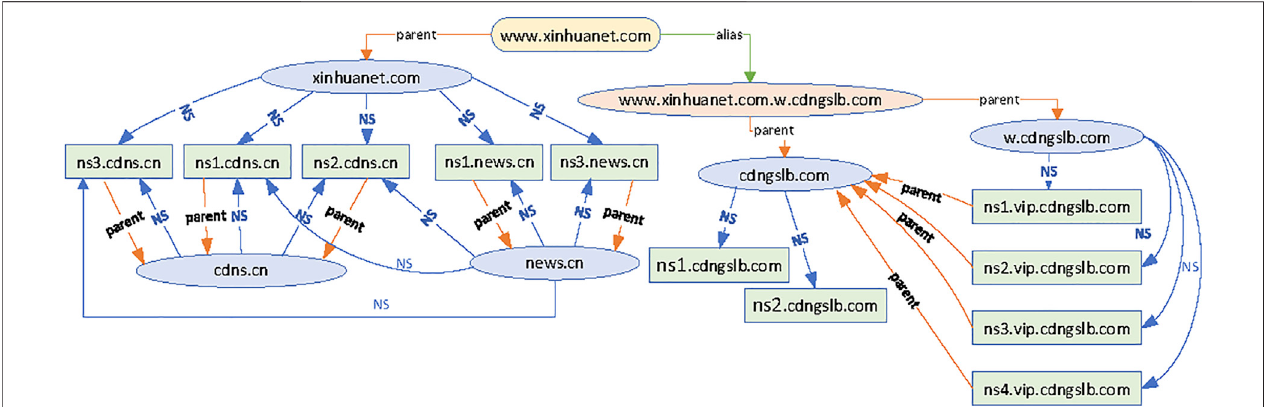
FIGURE 4 | An example of domain name dependency graph.